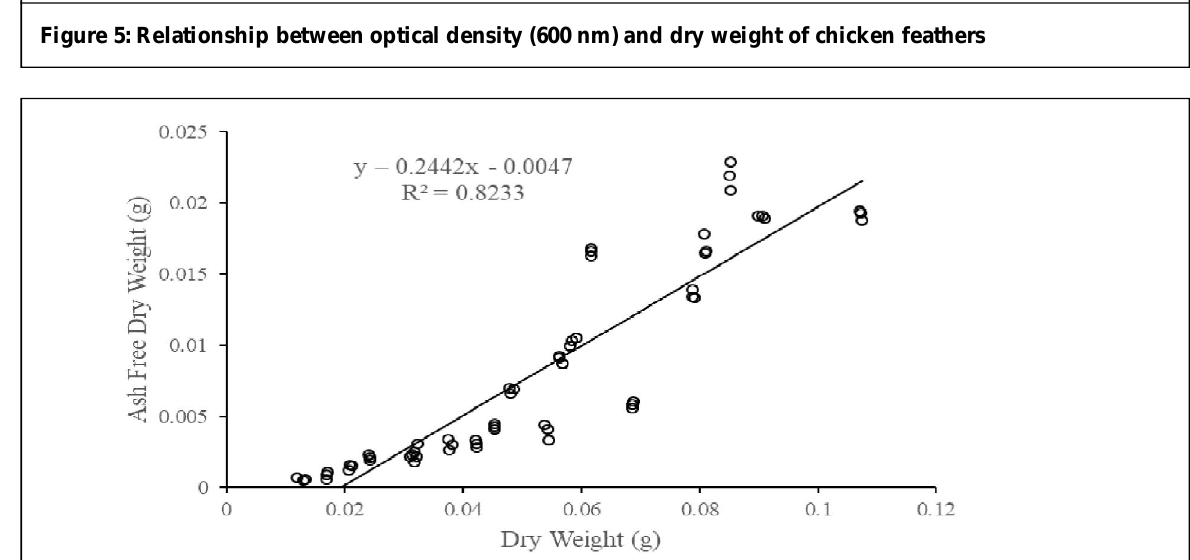
Figure 6: The relationship between dry weight and ash free dry weight of chicken